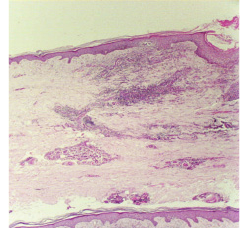
Figure 3 - Dense inflammatory infiltrate composed by lymphocytes, histiocytes and rare eosinophils, around the skin blood vessels with a strong thickness of the walls. (250X).